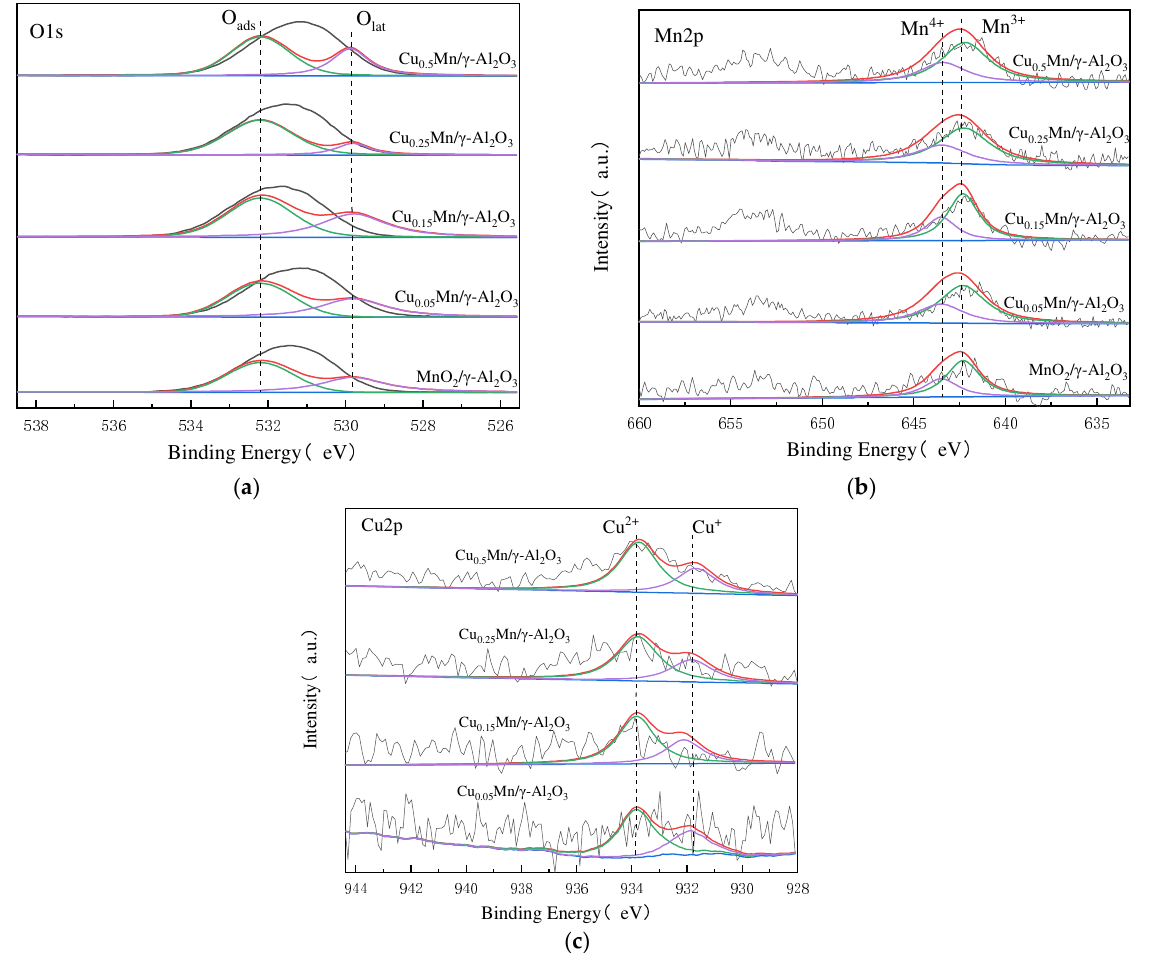
Figure 4. XPS curves of Cu-doped MnO 2 catalysts: ( a ) O1s; ( b ) Mn2p; ( c ) Cu2p.